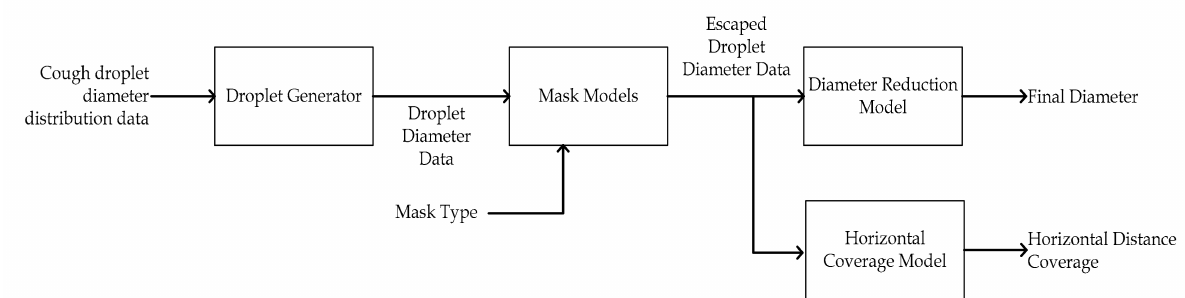
Figure 4. The environmental models for predicting the droplet diameter reduction and horizontal coverage.